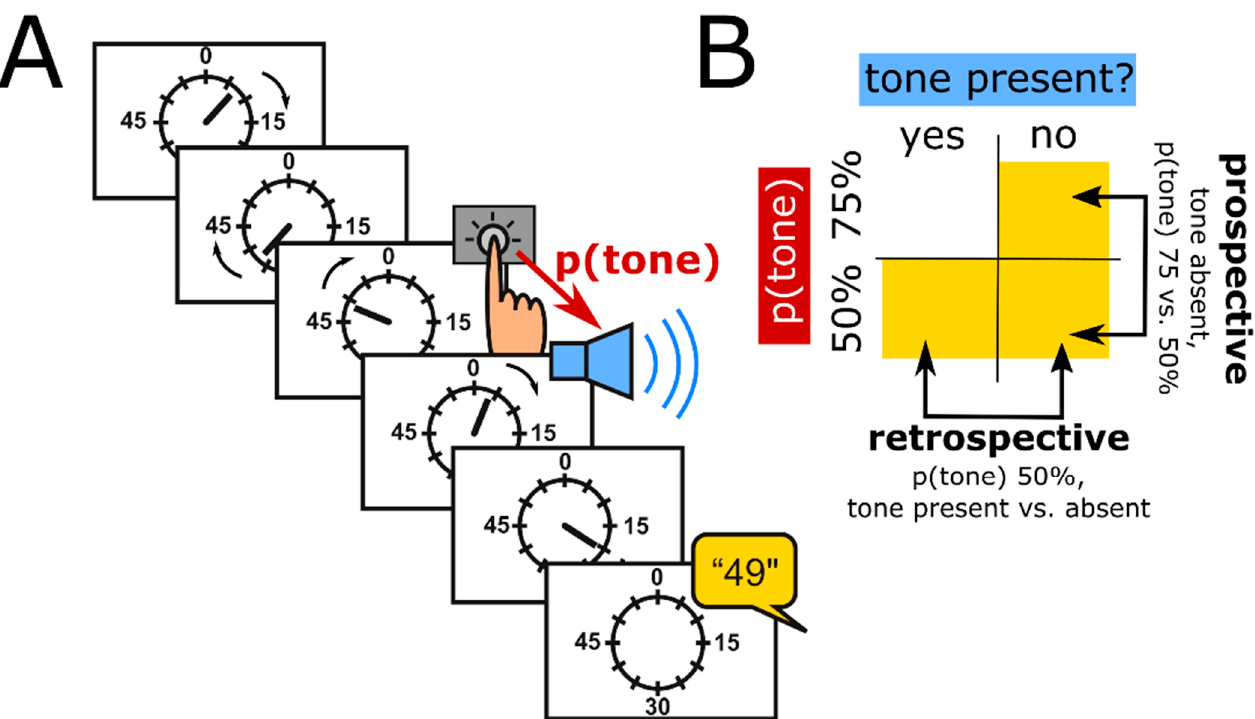
Figure 1. Schematic of the classic intentional binding paradigm ( A ) and design of a variant of that paradigm, which dissociates prospective and retrospective components of intentional binding ( B ). p(tone), probability of tone presentation after a keypress.